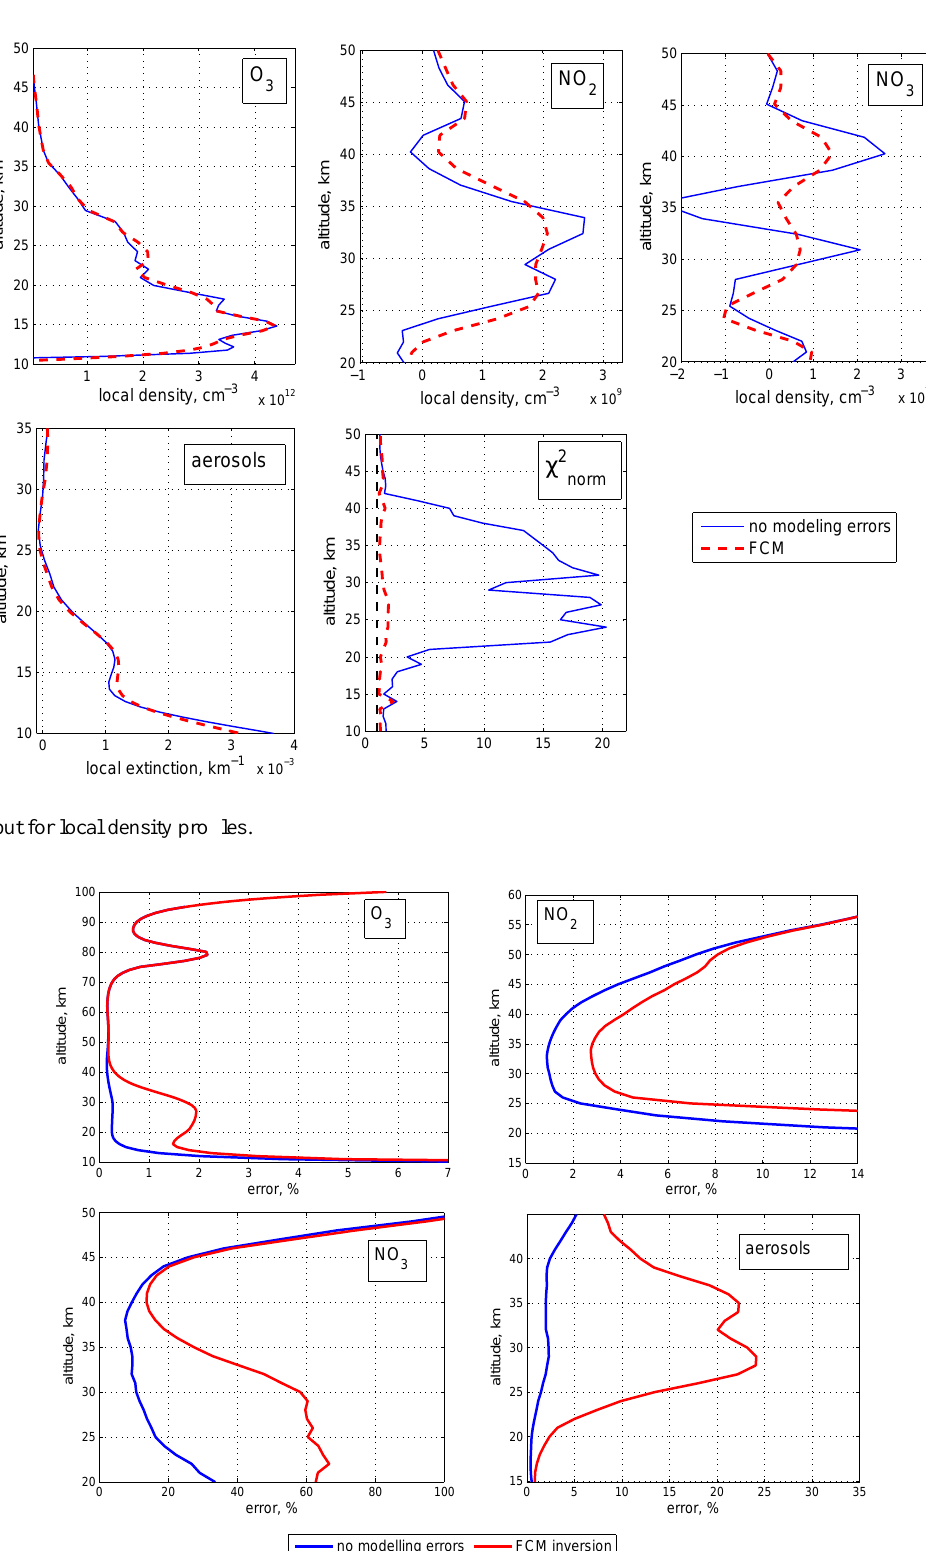
Fig. 5. Error estimates of local densities, for cases of ignored modeling errors and FCM inversion. The measurements from the set 2 (Table 1) were used for the